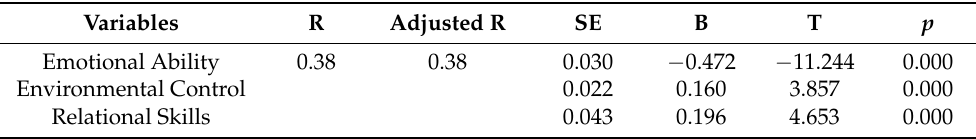
Table 10. Model summary of hierarchical regression analysis that predicts the school